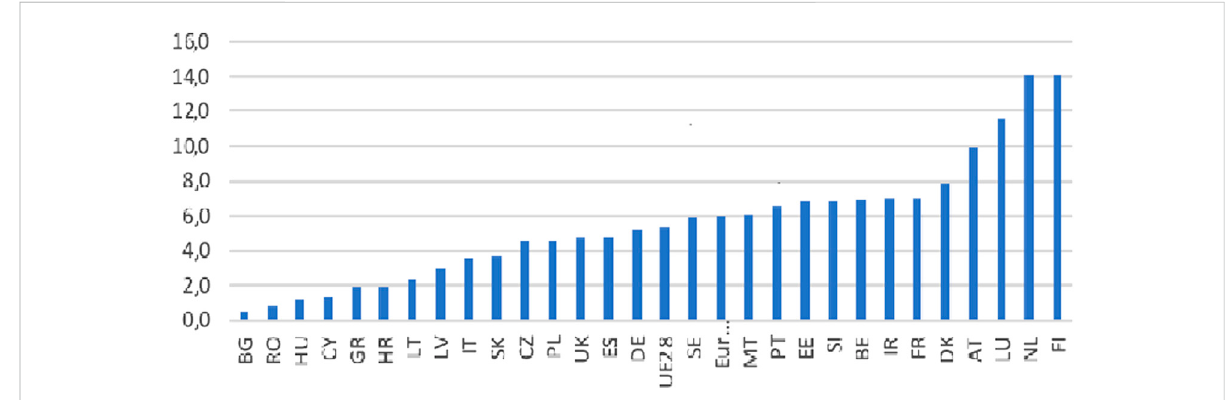
FIGURE 1 Employed persons usually working from home (% of total population 15 – 64 years,